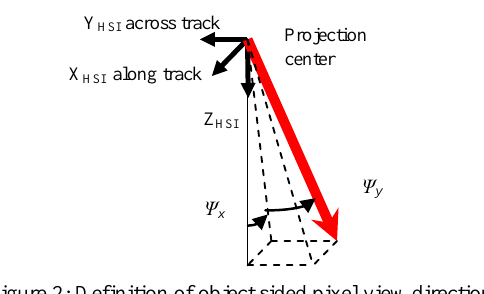
Figure 2: Definition of object sided pixel view